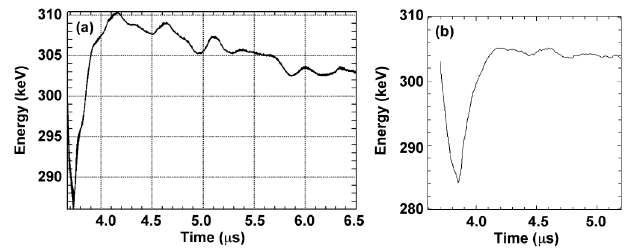
FIG. 11. Longitudinal phase space distributions calculated in: (a) LSP ; and (b) WARP .